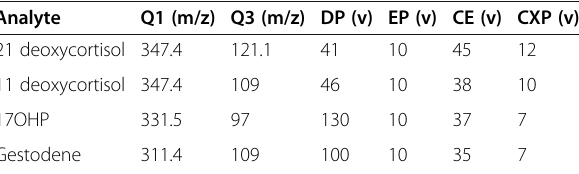
Table 1 Operating conditions of LC-MS/MS to monitor 21 deoxycortisol, 11 deoxycortisol, 17OHP Analyte